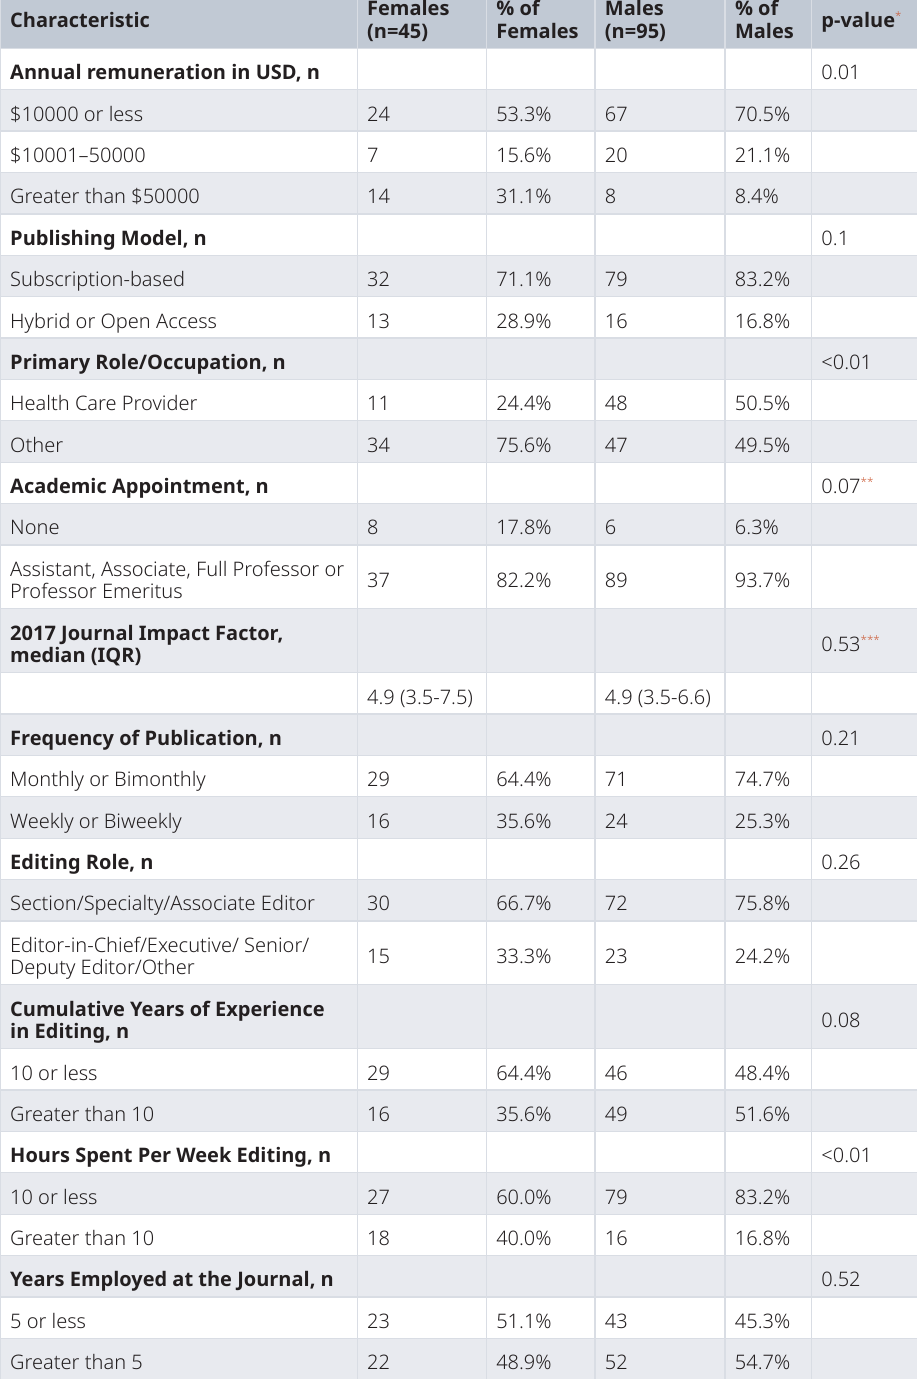
Table 1. Baseline characteristics of survey respondents, by